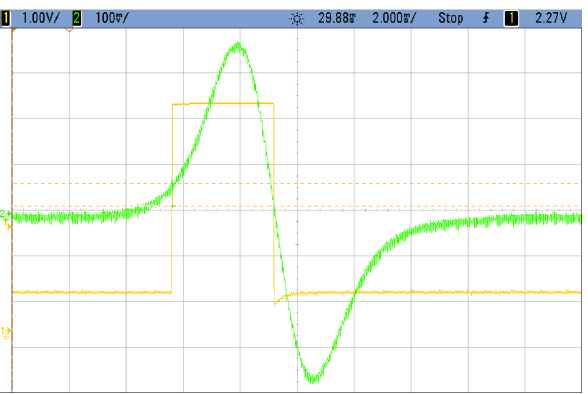
Figure 8. Output signal of a phonic-wheel inductive sensor with asymmetric rise and fall